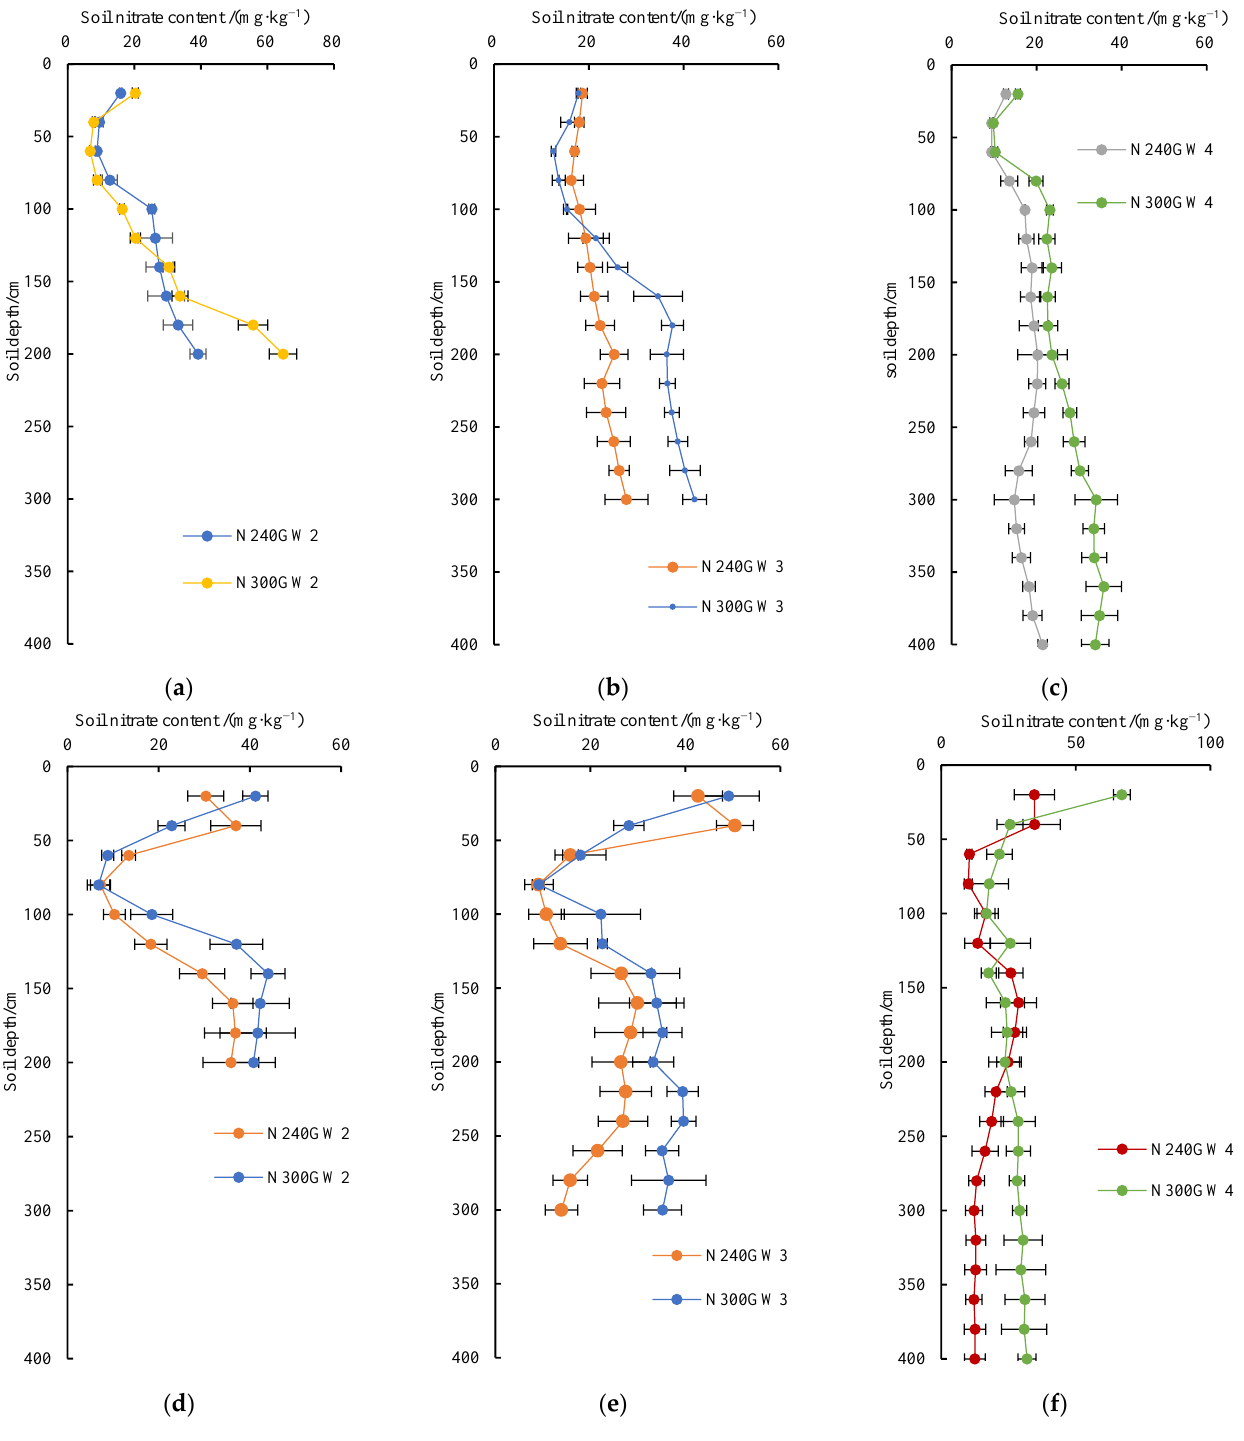
Figure 5. Soil nitrate content at different soil depths at the maturity stage of of summer maize and winter wheat. ( a ) GW2 in summer maize; ( b ) GW3 in summer maize; ( c ) GW4 in summer maize; ( d ) GW2 in winter wheat; ( e ) GW3 in winter wheat; ( f ) GW4 in winter wheat. The residual soil nitrate accumulation in the summer maize and winter wheat fields was affected directly by the groundwater depths and the nitrogen application amounts (Tables 4 and 5). The N300 treatment increased the residual soil nitrate accumulation by 36.02% and 35.55% in the entire soil profile for summer maize and winter wheat, respec- tively. The residual soil nitrate accumulation in the entire soil profile of summer maize